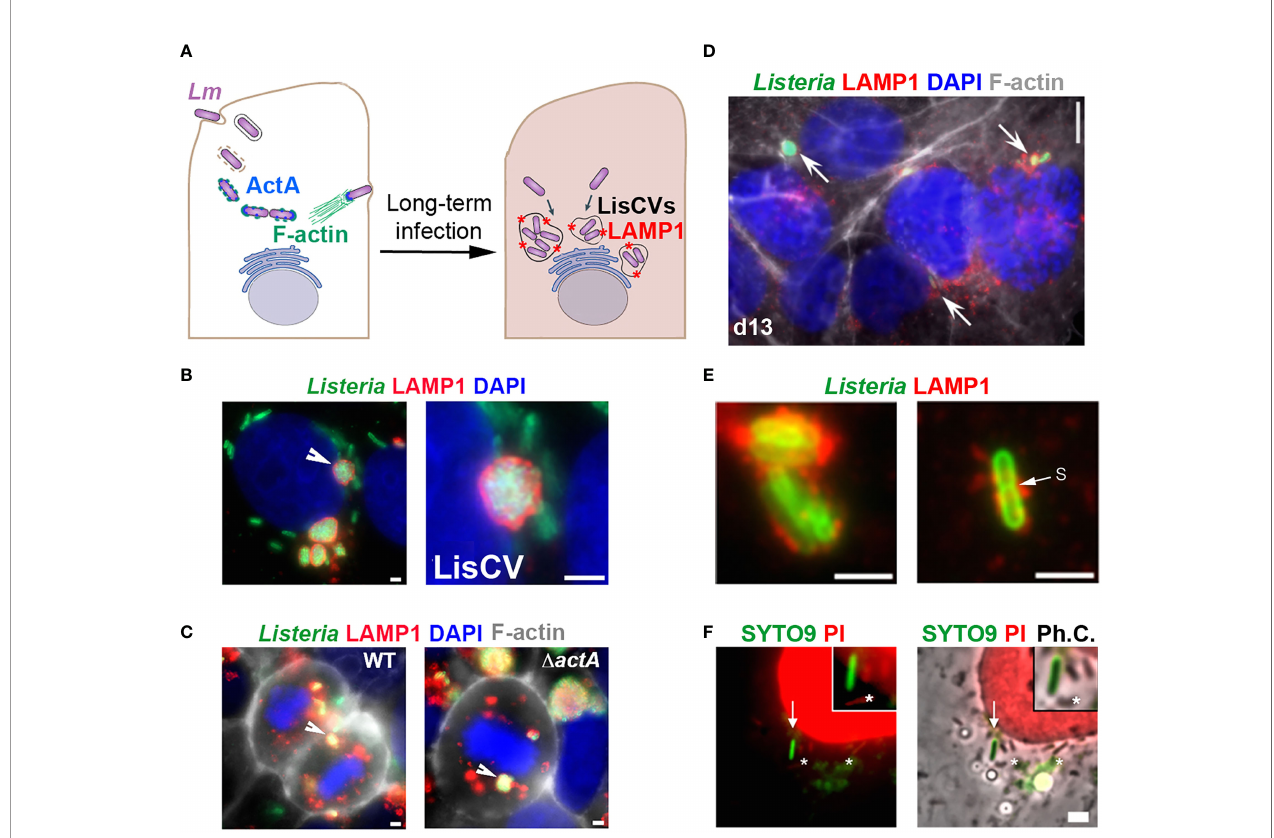
FIGURE 1 | Evidence for an intracellular VBNC state of L. monocytogenes (adapted from (Kortebi et al., 2017). (A) Simpli fi ed diagram of the different phases of the intracellular life of Lm in epithelial cells. Bacteria are internalized into the host cell and are contained in an entry vacuole. After escape into the cytosol, bacteria multiply and produce ActA, which allows them to polymerize actin (F-actin), move into the infected cell, and spread to adjacent cells (not shown). After a few days of infection, cytosolic bacteria cease to produce ActA and are captured in membrane compartments, forming Listeria-containing vacuoles (LisCVs) marked with LAMP1 (represented by red stars). In these acidic vacuoles, a subpopulation of bacteria can resist degradation and multiply slowly, up to entry into dormancy. (B, C) Observation of LisCVs by epi fl uorescence microscopy in human placental JEG3 cells infected for 3 days with Lm . LisCVs labelled with LAMP1 are in red, Listeria in green, DNA (stained with DAPI) in blue, and F-actin in white. (B) A cell contains several perinuclear LisCVs. The arrow indicates a LisCV shown at higher magni fi cation in the image on the right. Bars: 2 m m. (C) LisCVs are present in mitotic cells infected with either the wild-type Lm strain (WT, left) or a D actA mutant (right). Bars: 2 m m. White arrows indicate representative LisCVs. (D – F) Subculturing of JEG3 cells infected with D actA bacteria leads to VBNC bacteria. (D) Cells infected for 3 days were subcultured and propagated until day 13 (d13) and stained as in (C) . Intracellular bacteria in LAMP1-positive compartments are indicated by arrows. At the same time, plating of infected cell lysates onto agar plates produces no colony (not shown). (E) High magni fi cation images of non-culturable LAMP1- positive bacteria at d13. A bacterium with a division septum (s) is shown on the right. Bar: 5 m m. (F) JEG3 cells infected with non-culturable bacteria were permeabilized with 0.1% Triton X-100 and stained with SYTO9 and PI (see BacLight assay, Table 1 ). Intact VBNC bacteria are stained green (arrow), while damaged bacteria (*) and nuclei are stained red. “ Ph.C. ” : phase contrast. Bar: 1 m m. The top right squared images show higher magni fi cations, with one bacterium with an intact membrane (green) and three bacteria with a compromised membrane